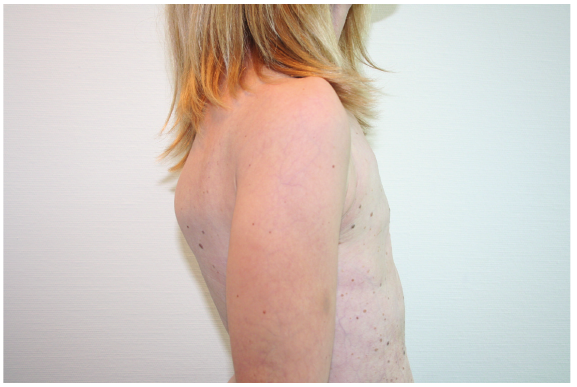
Figure 4: Preoperative lateral view, showing total absence of the mammary mound.